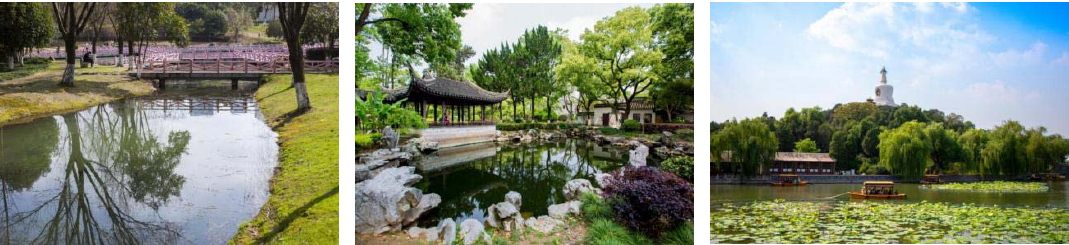
Figure 6. Landscape color tendency.